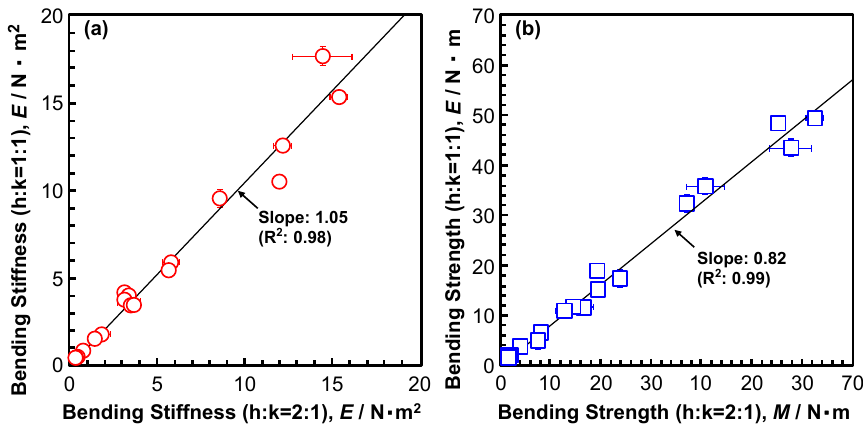
Figure 2. Effect of h:k ratios (h:k = 1:1 or h:k = 2:1) on ( a ) four-point bending stiffness and ( b ) bending strength obtained from four-point bending tests with the same eight-hole bone plates.